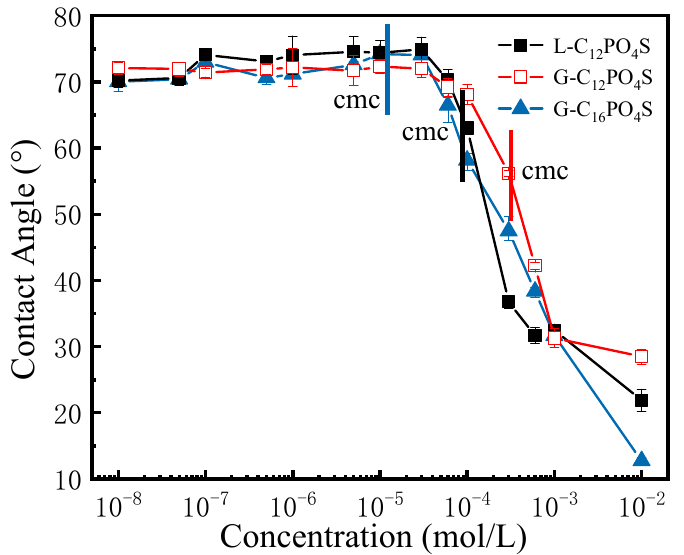
Figure 2. Effect of concentration on contact angles ( θ ) of the extended surfactant solutions on polymethylmethacrylate (PMMA) surface.